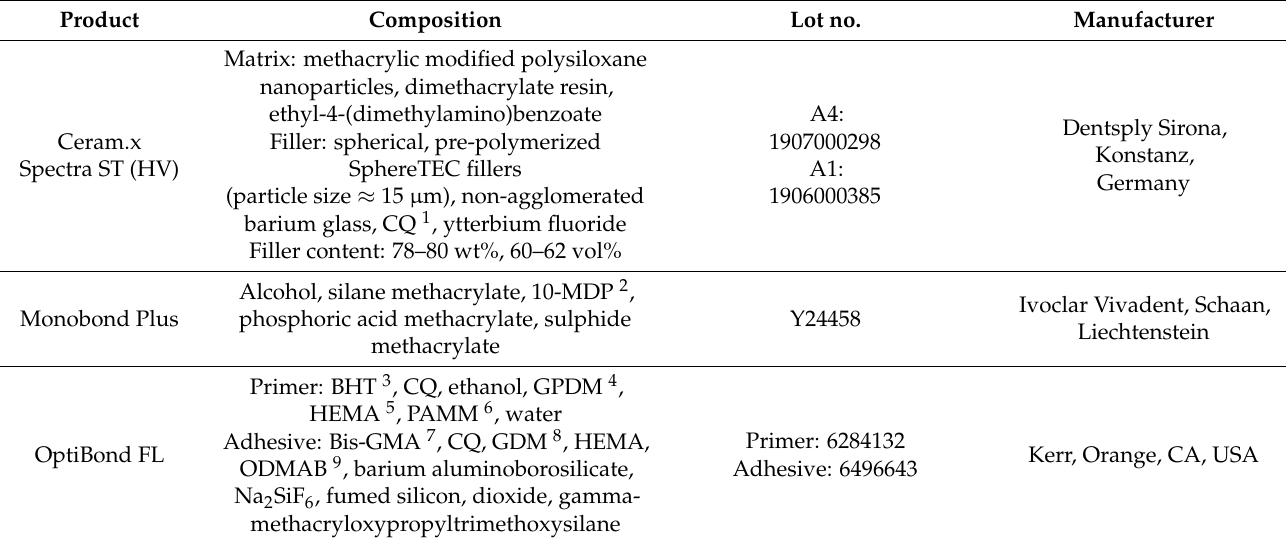
Figure 1. Experimental design. Table 1. Manufacturers’ information about the main materials used in the present